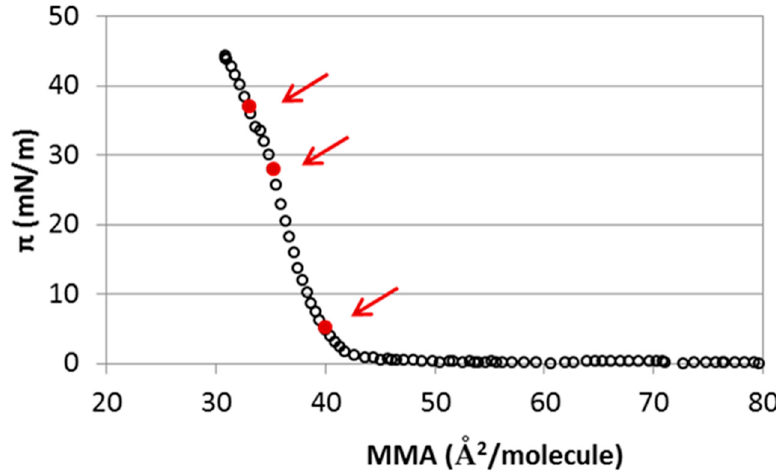
Figure 1. Surface pressure ( π ) vs. area per molecule (MMA) isotherm of cholesterol (CHOL) monolayers in a 15 mM NaCl subphase. The arrows indicate the particular cases analyzed by molecular dynamics (MD) simulations: 33.1 Å 2 /molecule; 35.3 Å 2 /molecule and; 40 Å 2 /molecule (standard deviation <2%).